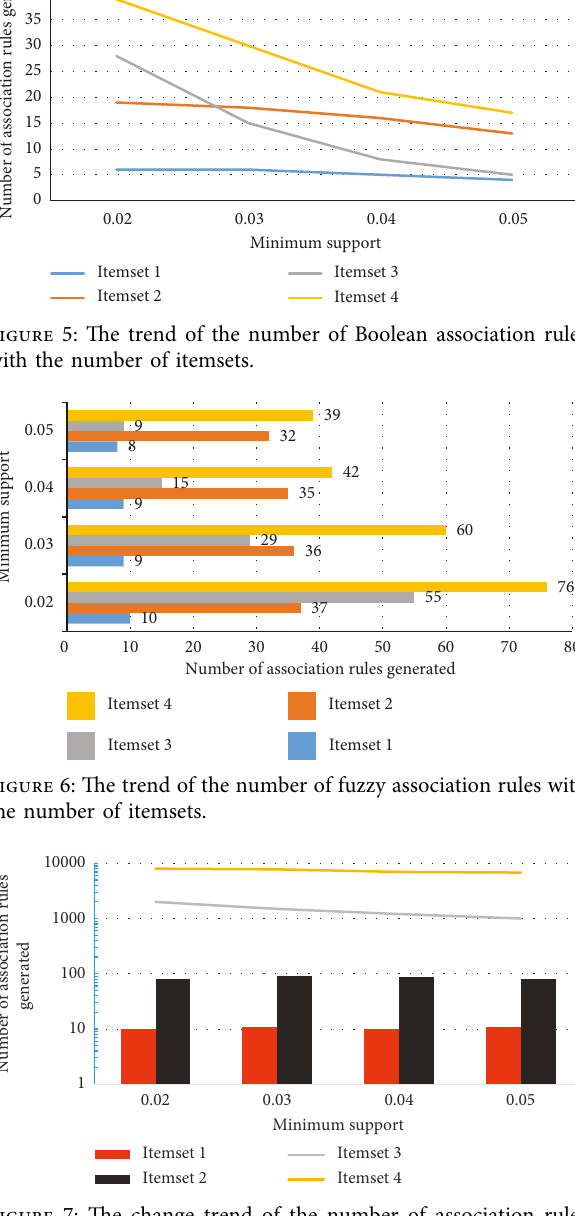
Table 4: Comparison of accuracy and recall rates of two methods in small data.